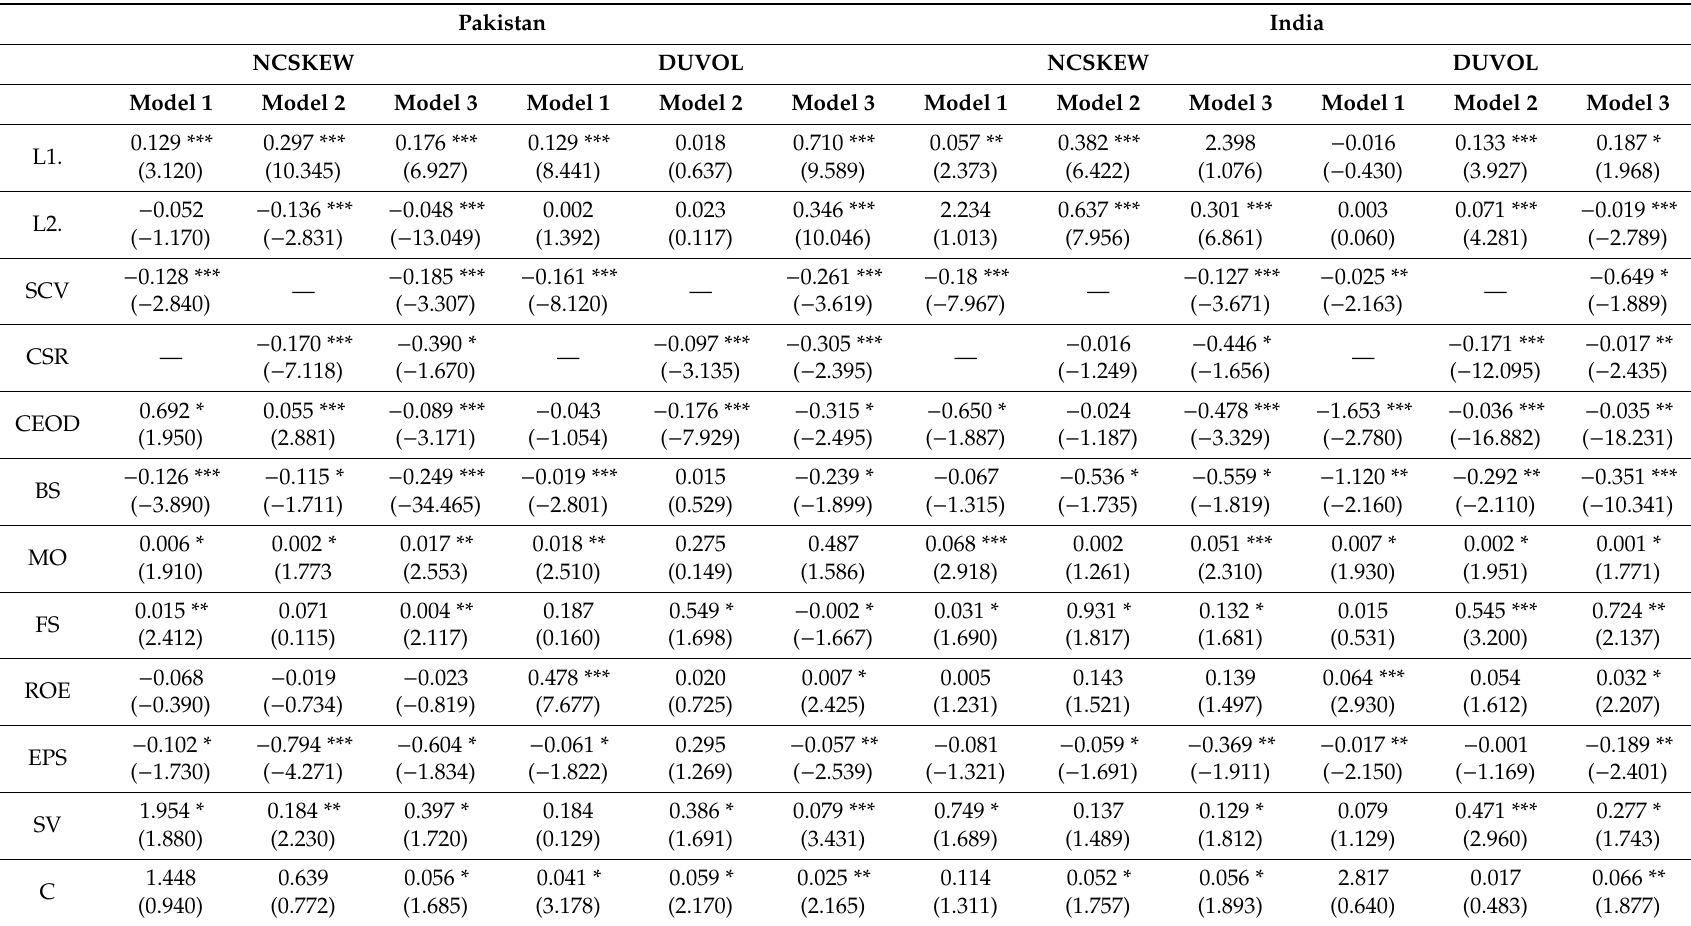
Table 5. Two-step dynamic panel estimation